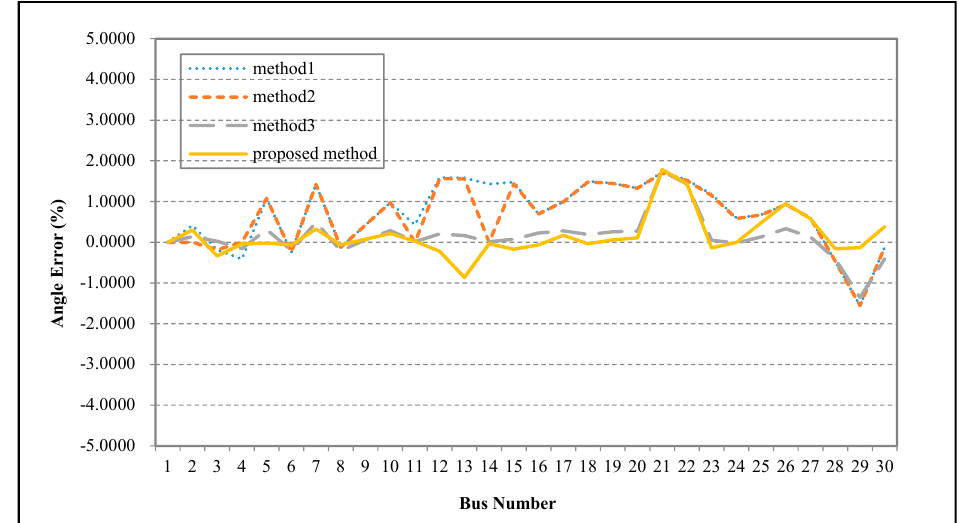
Figure 15. The percentage of bus voltage angle estimate error in 30 bus system.